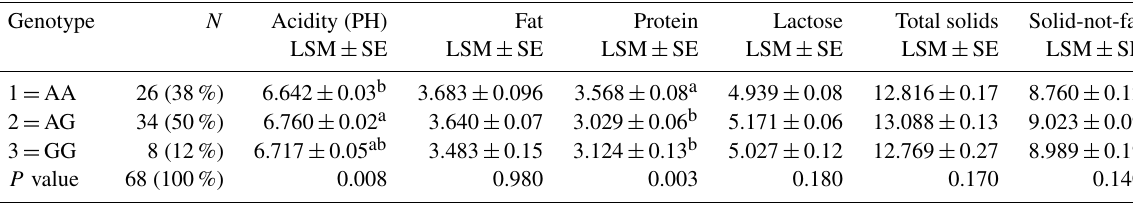
Table 2. Effect of CSN2 genotypes on milk chemical compositions (%) in Maghrebi camels. Genotype N Acidity (PH) Fat Protein Lactose Total solids Solid-not-fat LSM ± SE LSM ± SE LSM ± SE LSM ± SE LSM ± SE LSM ± SE 6.642 ± 0.03 b